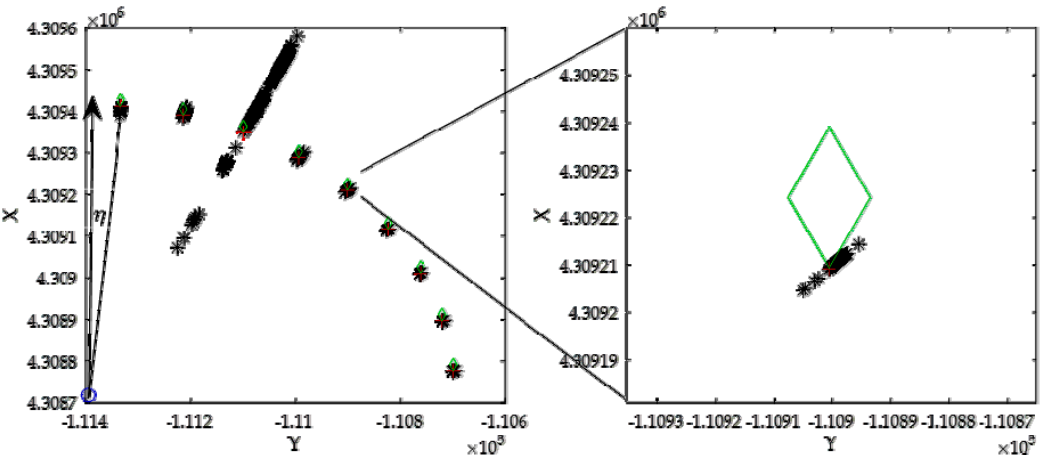
Figure 5. Positioning results at different locations.